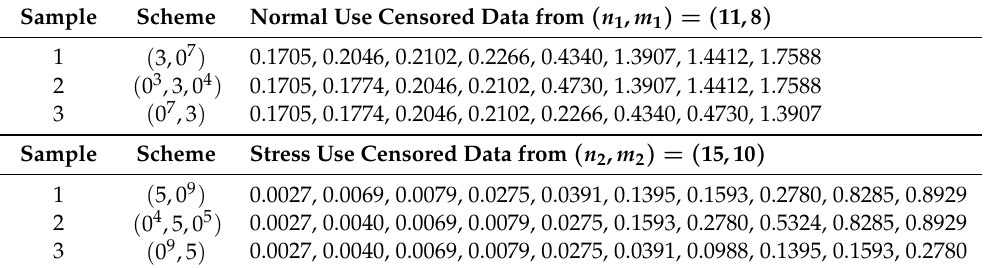
Table 2. Various constant stress PC-T-II samples from OBT data.